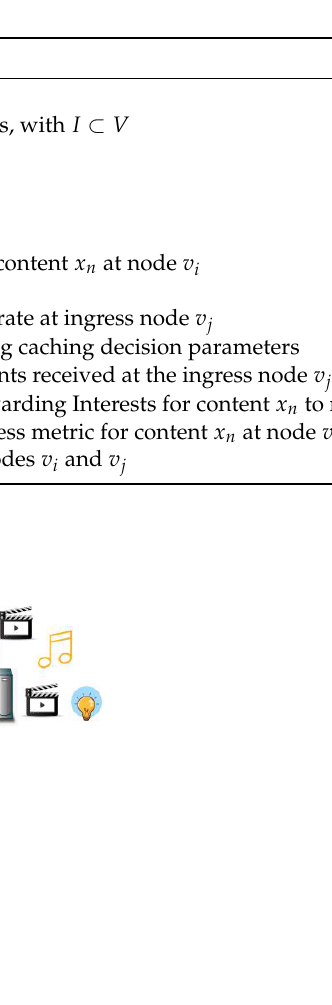
Figure 2. Reference